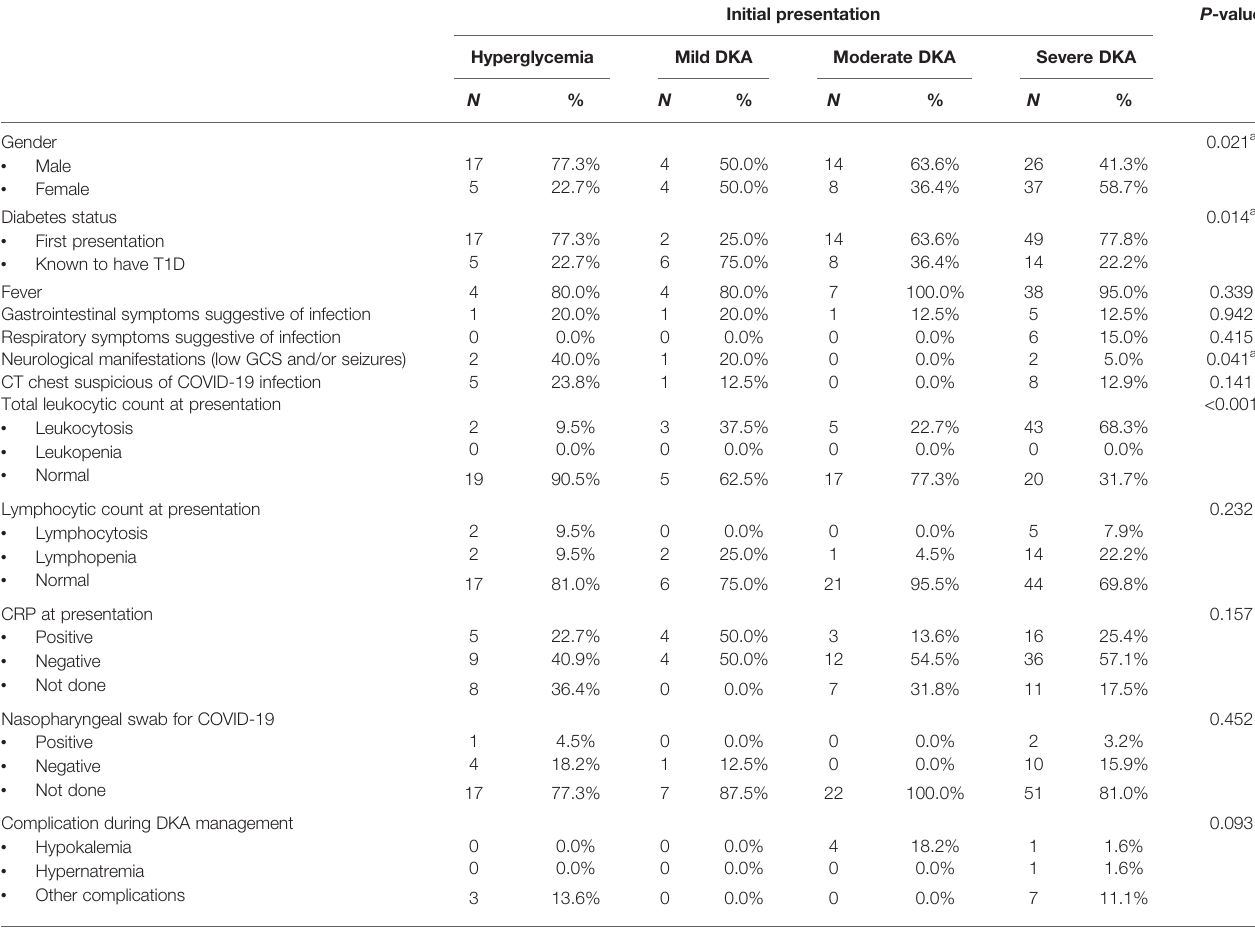
TABLE 2 | Association of the grades of severity of DKA and the enlisted variables in the fi rst COVID-19 wave.